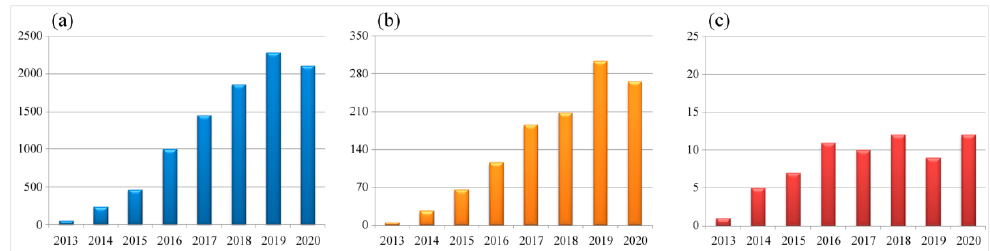
Figure 1. Numbers of scientific reports focused on CRISPR and gene editing during 2013–2020. ( a ) Total number of publications in the field of life sciences. ( b ) Total number of publications in the field of virology. ( c ) Numbers of virus species being studied each year. Data are collected from the NCBI PubMed database (27th March 2021), searched with the keywords CRISPR plus gene editing or CRISPR plus virus and gene editing, respectively.